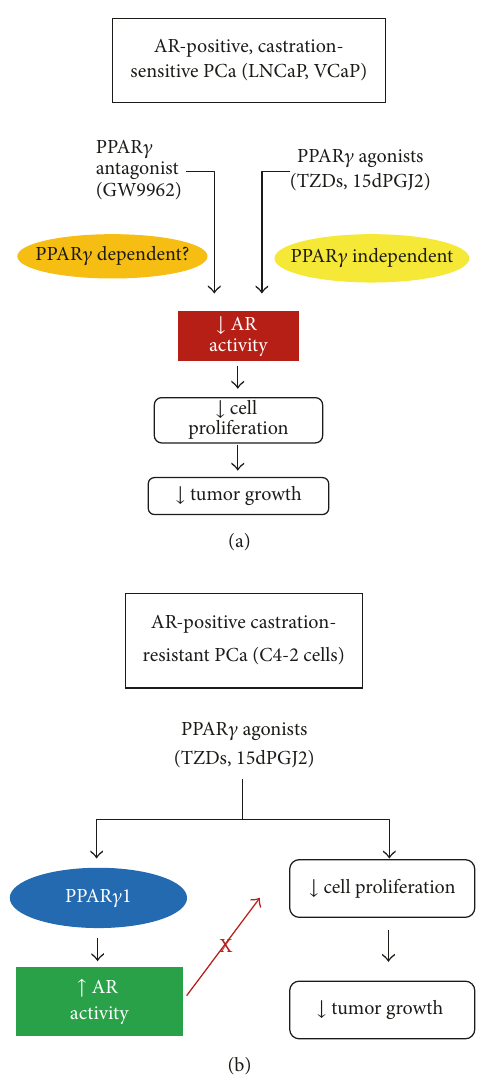
Figure 1: PPAR 𝛾 ligands regulate AR signaling within human prostate cancer cells. In AR-positive castration-sensitive prostate cancers such as LNCaP and VCaP cells (a), PPAR 𝛾 agonists and the PPAR 𝛾 antagonist GW9662 have been shown to decrease AR transcriptional activity. Agonist-induced reductions in AR signaling appear to occur independently of PPAR 𝛾 , while it is currently not known if PPAR 𝛾 is required for GW9662-induced reductions in AR activity. It is believed that these reductions in AR signaling contribute to the antiproliferative and antitumor effects of PPAR 𝛾 ligands in these early stage cancers. Conversely, PPAR 𝛾 agonists appear to enhance AR signaling via a PPAR 𝛾 1-dependent mecha- nism in the AR-positive, castration-resistant C4-2 cells (b). Data suggest that the antiproliferative effects of PPAR 𝛾 agonists in AR- positive cells do not require PPAR 𝛾 and appear to occur indepen- dently of any increases in AR activity within these cells. However, since AR activation can drive growth of castration-resistant tumors, it is possible PPAR 𝛾 agonist-induced increases in AR activity may interfere with the net ability of these compounds to reduce cell proliferation and tumor growth in AR-positive, castration-resistant cancers.